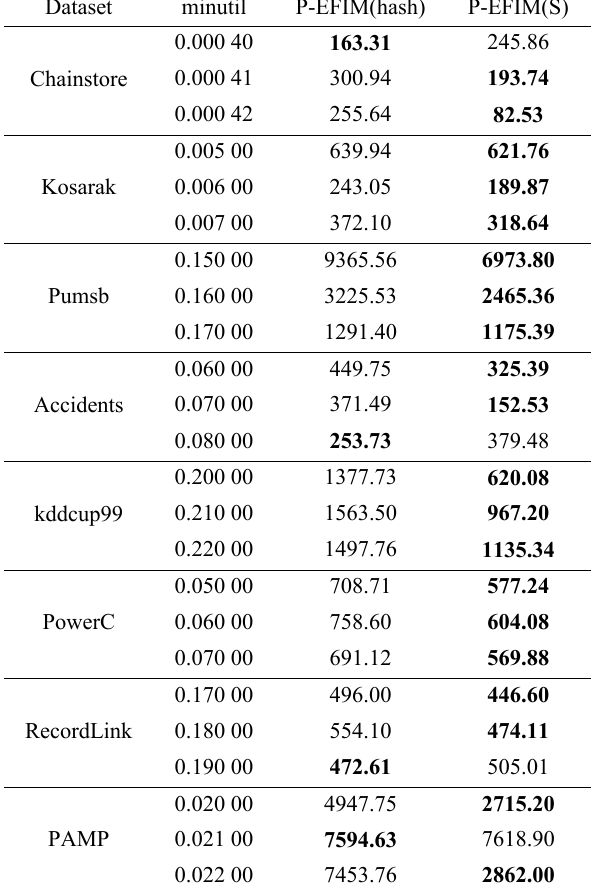
Table 6 Standard deviations of the two distribution strategies.